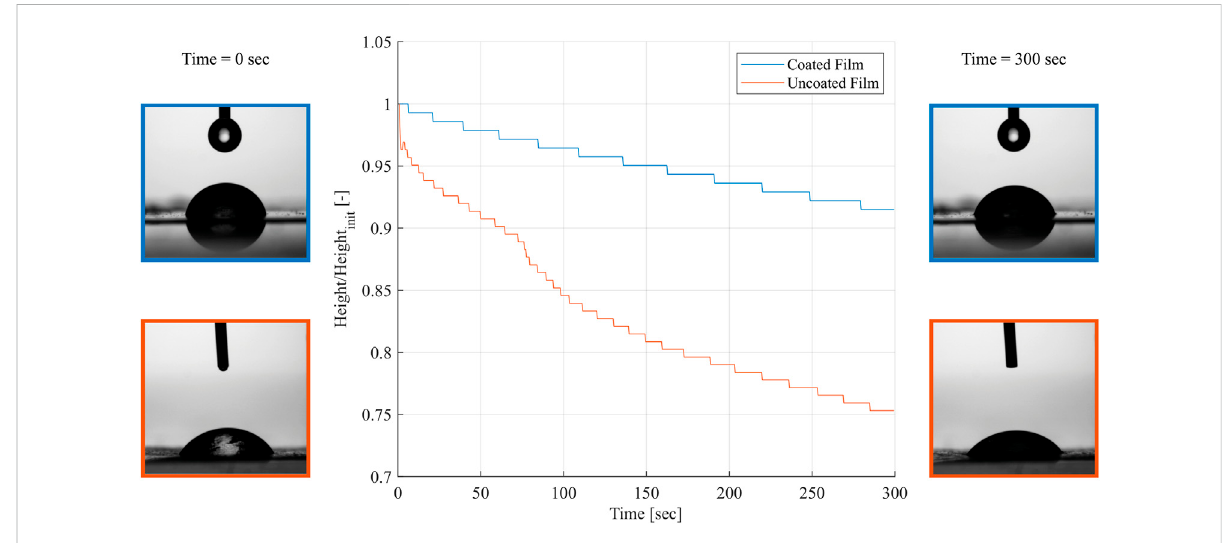
FIGURE 8 Representative time-dependent contact angle measurements of the coated and un-coated CNF:G — 0.25:0.75 fi lms for 5 min. The water droplet on the coated fi lm shows only minor reduction in height, while the droplet on the un-coated fi lm penetrates the fi lm